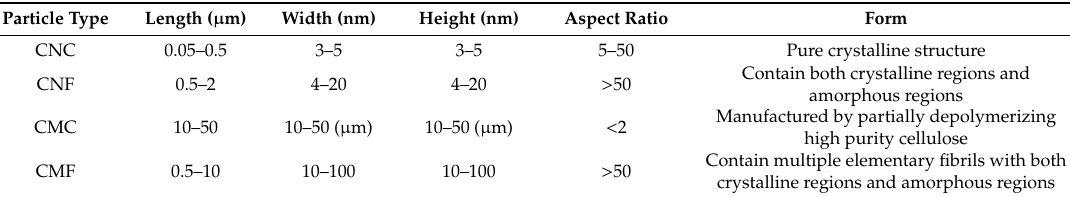
Table 1. Summary of several kinds of